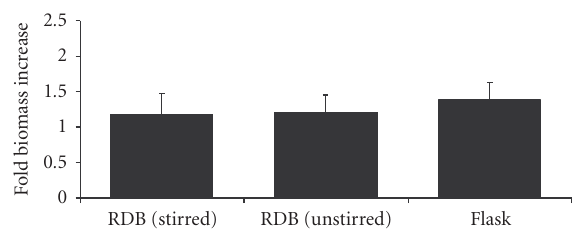
Figure 7: Cell growth in bioreactors versus standard vessels. Graph of biomass increase in EL-4 colonies after culture in rotating disc bioreactors with stirring (Re = 600) or without stirring, compared to values of static flask cultures. Bars represent a mean of 6 experi- mental groups; error bars represent standard error of that mean.